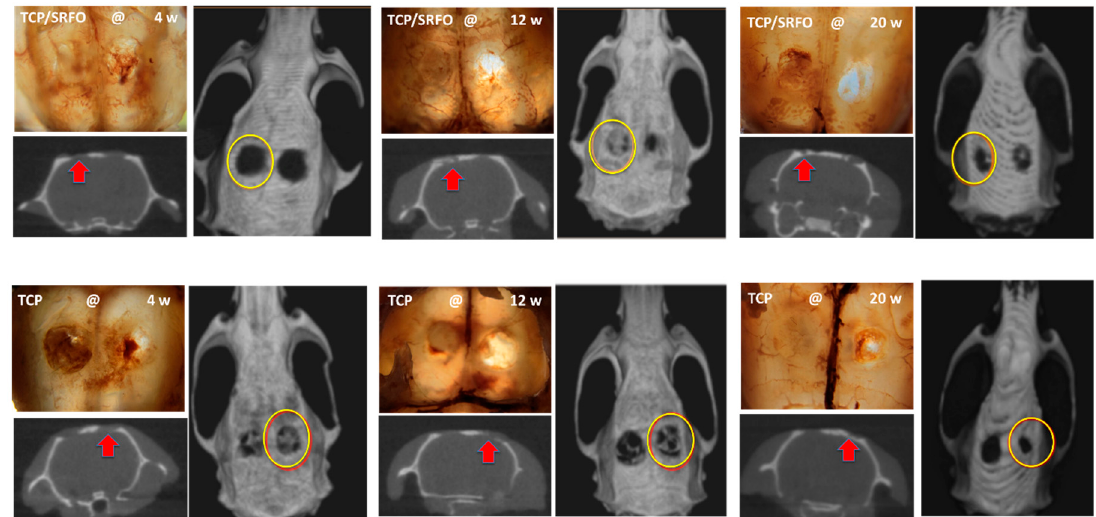
Figure 11. Healing evolution of treated cranial defects mediated by SrFO/TCP (upper) and TCP (lower) composite implants (circle or arrow) and without construct (control). Figure adapted from Martín-del-Campo et al. [16] with permission from The Royal Society of Chemistry.